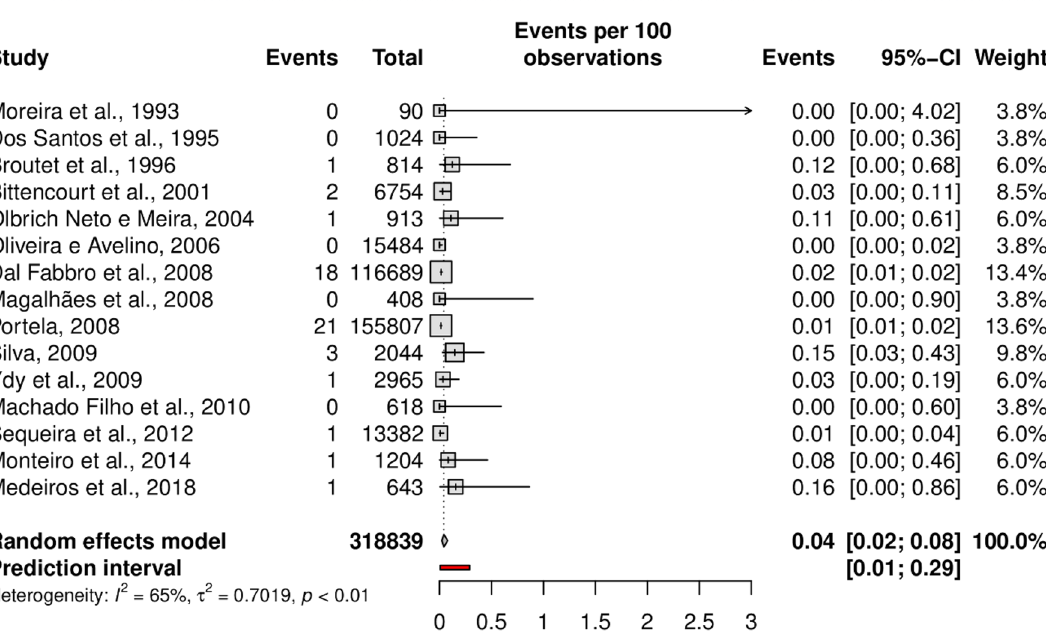
Figure 2. Forest plot of the prevalence of HTLV-1 infection, as detected by confirmatory tests, in pregnant women.